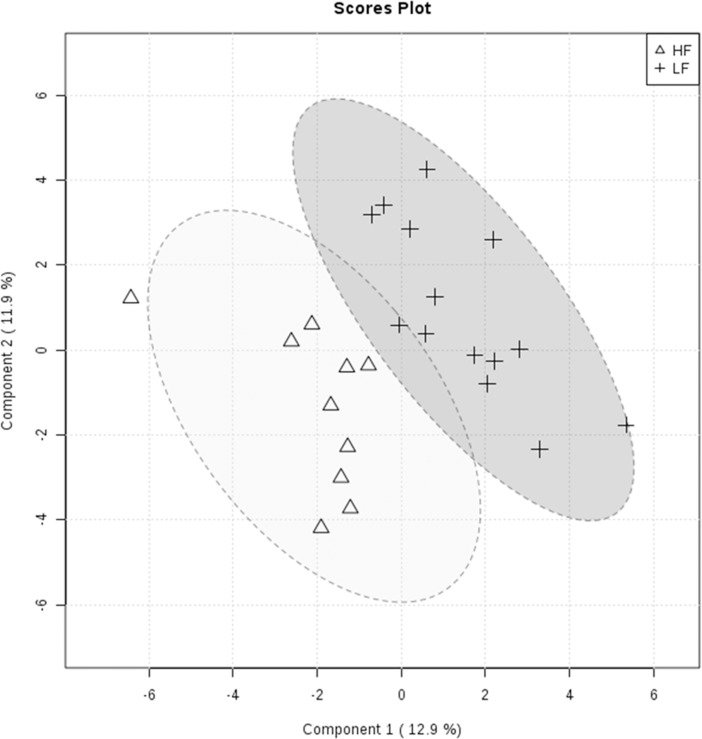
PLS-DA score plot of seminal plasma from high (HF) and low fertility (LF) bulls.The plots indicate that a separation could be observed between HF and LF bulls. Supervised PLS-DA was obtained with 2 components. The explained variances are shown in parentheses.